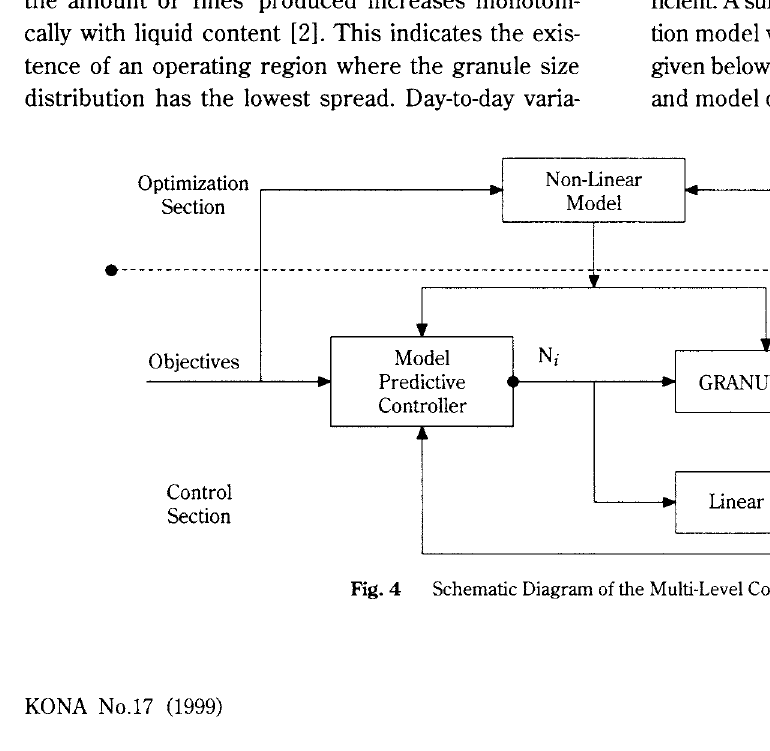
Fig. 4 Schematic Diagram of the Multi-Level Control